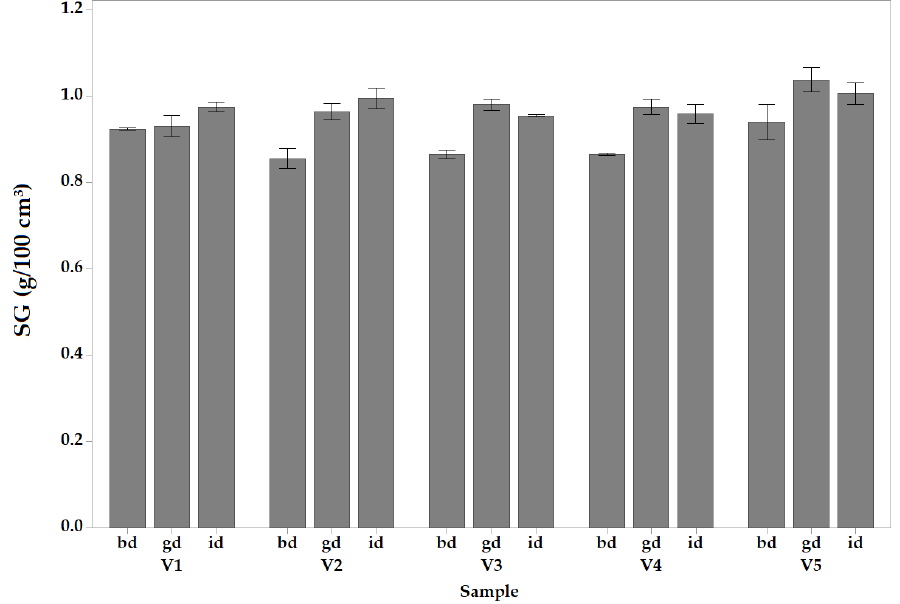
Figure 4. Interval plots of specific gravity (SG) vs. samples before digestion (bd); and after gastric digestion (gd); intestinal digestion (id). V1 = banana peel vinegar aged for 1 year, produced without boiling the peels boiling aged for 1 year, V2 = banana peel vinegar aged for 3 years, produced without boiling the peels boiling aged for 3 years, V3 = banana peel vinegar aged for 2 years, produced with peels boiling the peels aged for 2 years, V4 = commercial balsamic vinegar produced from concentrated apple juice and caramel aged in oak barrels for 1 year, V5 = Modena commercial vinegar obtained from concentrated grape must. The error bars represent a 95% confidence interval for the mean.